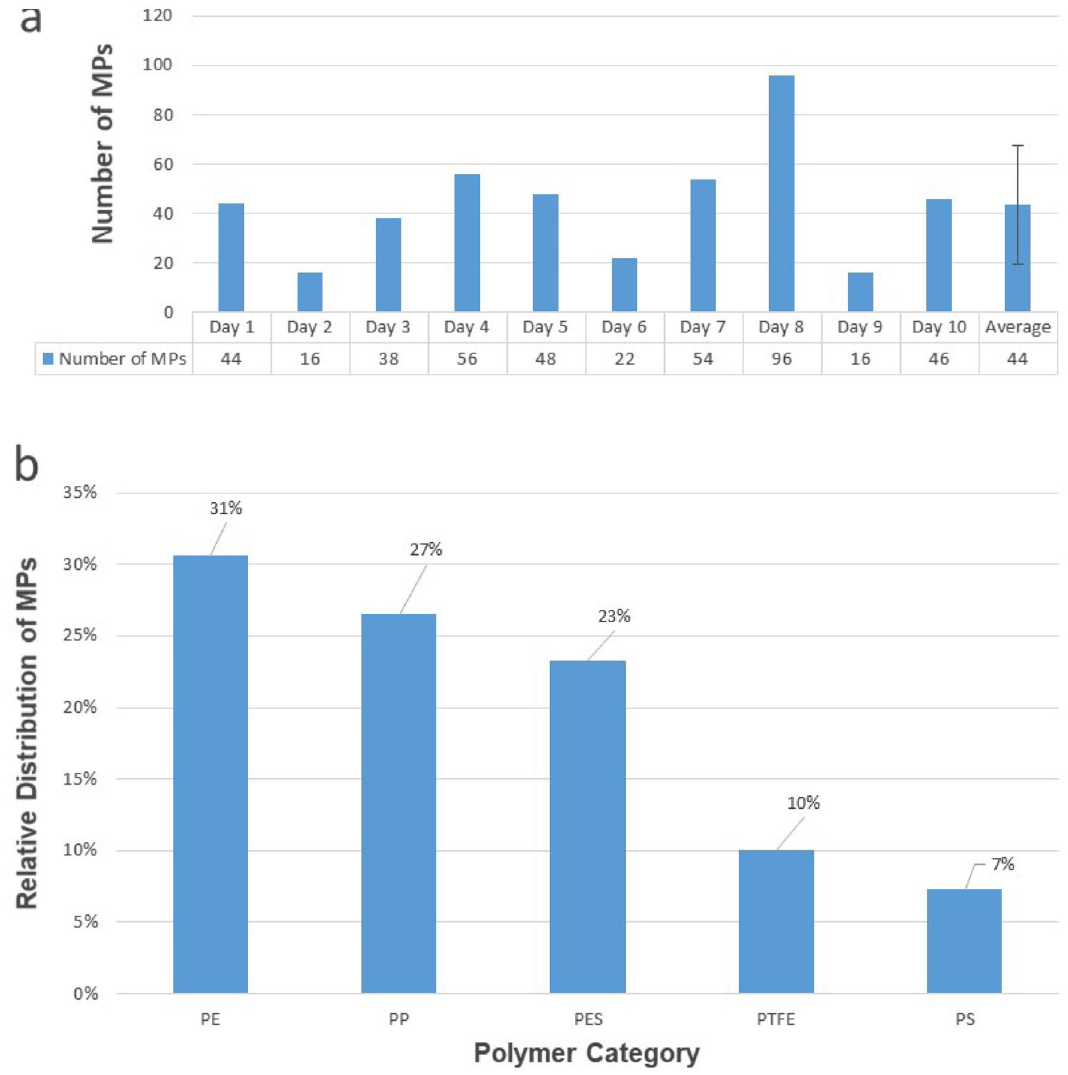
Figure 1. Monitoring of MPs contamination in method blanks. ( a ) Number of MPs in 10 procedural blanks; ( b ) relative distribution of MPs in the method blanks based on pol3: ymer type. Spiked samples a PMMA (%) PS (%) PP (%) PE (%) PA (%) Ultra-pure water (N = 7) without digestion 78 ±